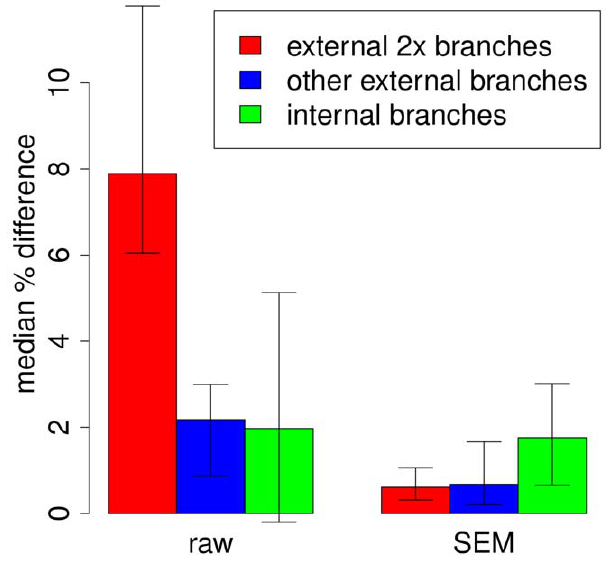
Figure 5. Estimated percent error in indel rates. Results are shown for the raw and error-mitigated (SEM) data sets. Indel rates were inferred using a probabilistic indel model and an expectation maximization algorithm (Methods S1), and percent error was estimated by comparing the rates for each data set with ones based on the highest quality sites only ( q $ 45). The median across the branches within each group is shown, with error bars indicating upper and lower quartiles. Results are shown for three groups of branches from the 32- species phylogeny: external branches corresponding to 2 6 species (red), all other external branches (blue), and internal branches (green). The indel rates fir the external 2 6 branches are overestimated by nearly 8% with the raw data, but that the SEM procedure eliminates most of this effect. There is also a substantial amount of overestimation associated with non-2 6 external branches stemming from lower-quality draft assemblies, such as the chimpanzee, and the SEM procedure effectively reduces this error as